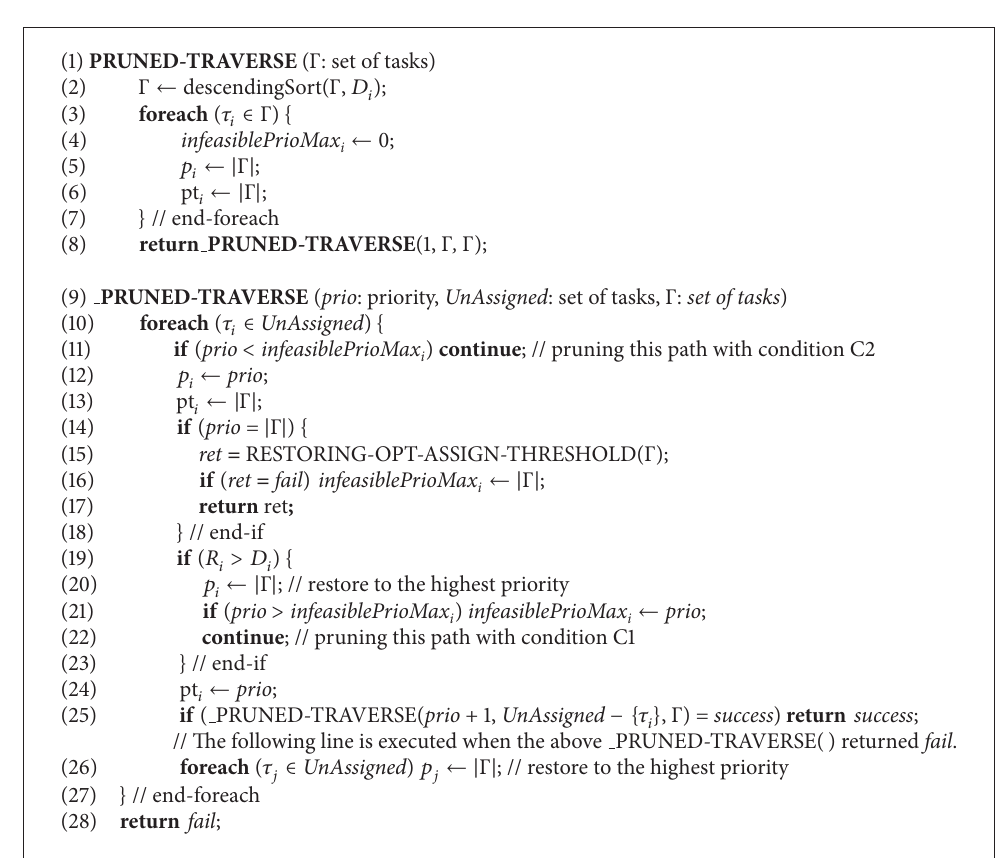
Algorithm 2: Pseudo code for (a) CORRECTED-SEARCH() and (b) RESTORING-OPT-ASSIGN-THRESHOLD( ).